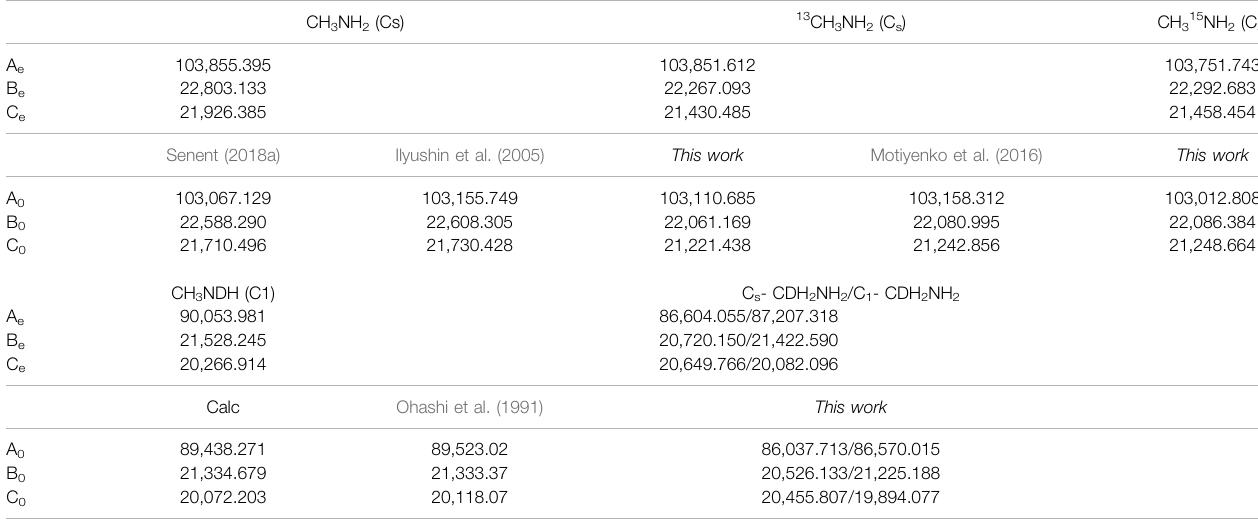
TABLE 1 | Rotational constants (in MHz).